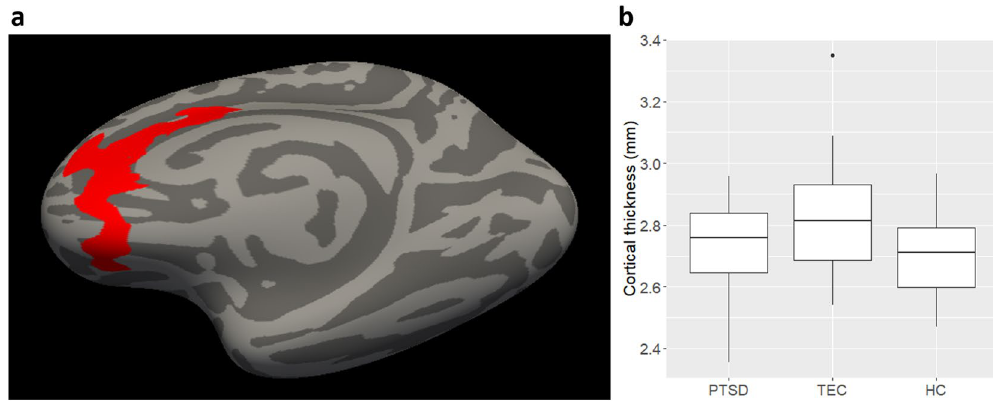
Figure 1. Cluster analysis showing significant differences in cortical thickness among the post-traumatic stress disorder, trauma-exposed controls, and healthy control groups. ( a ) Cluster projected onto the inflated surface of the right hemisphere. ( b ) Cortical thickness of the cluster for all groups. In the box plots, lines within the boxes denote median values, boxes extend from the 25th to the 75th percentile, whiskers denote adjacent values (i.e., the most extreme values within 1.5 times the interquartile range of the 25th and 75th percentiles), and dots denote outliers outside the range of adjacent values. PTSD post-traumatic stress disorder group, TEC trauma- exposed controls, HC healthy controls.